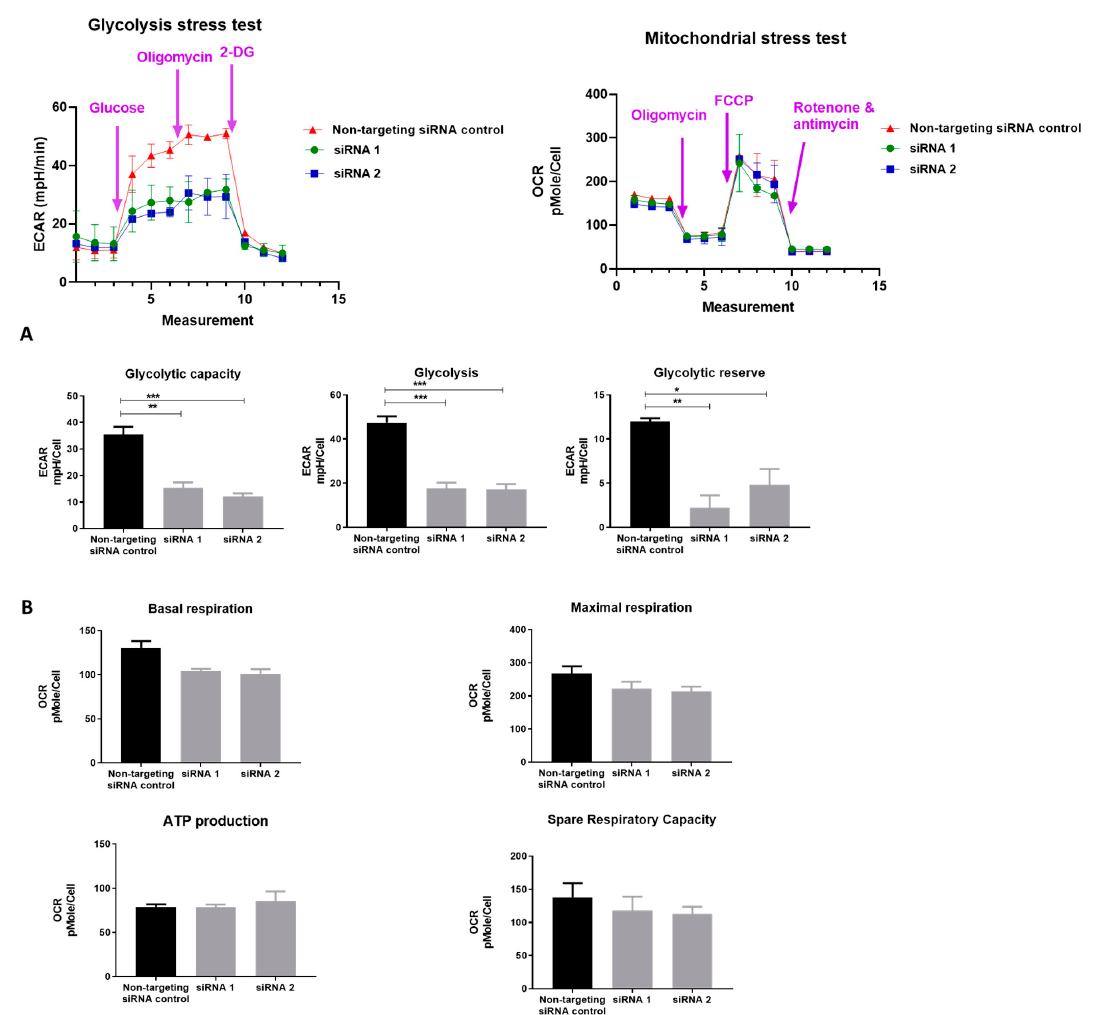
Figure 3. PDK1 knockdown inhibits glycolysis and does not affect mitochondrial respiration in LNCaP cells. ( A ) LNCaP cells were seeded in Seahorse XFe96 cell culture microplates. The cells were treated with 10 nM of siRNAs for 72 h, followed by sequential treatment with glucose (10 mM), oligomycin (ATP synthase inhibitor) (1 μ M) and 2-DG (glycolytic inhibitor) (100 mM). Extracellular acidification rate was measured. PDK1 siRNAs reduced all three glycolytic parameters